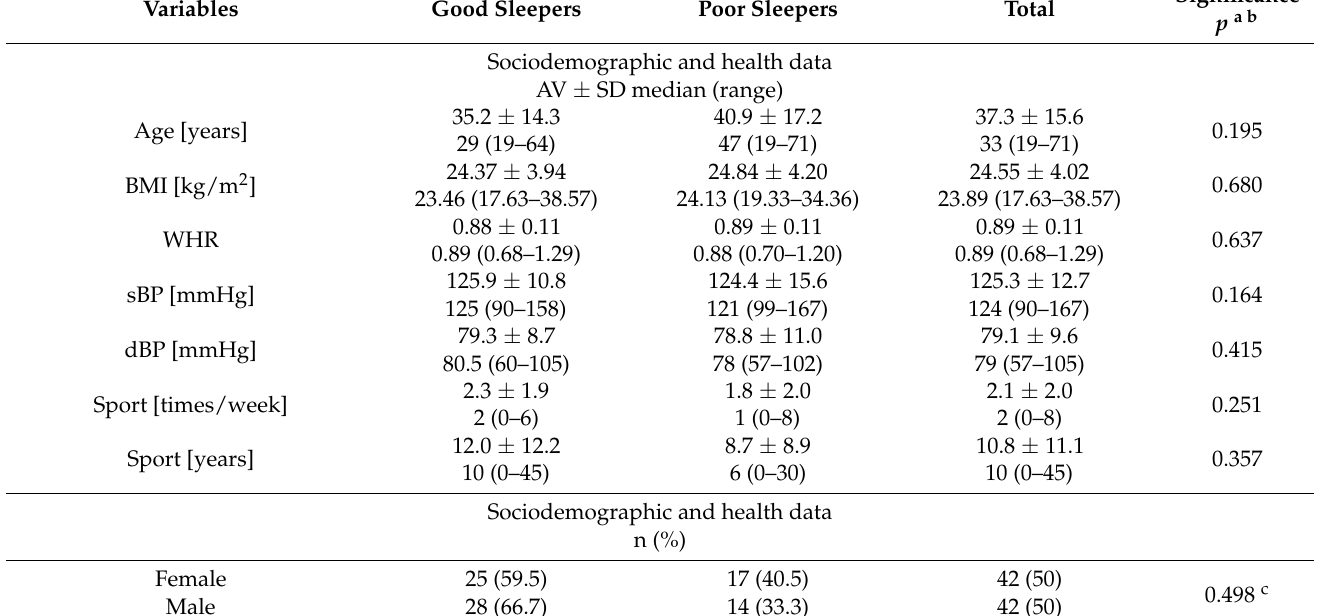
Table 2. Sociodemographic and health data as well as sleep quality and mental health of both groups.